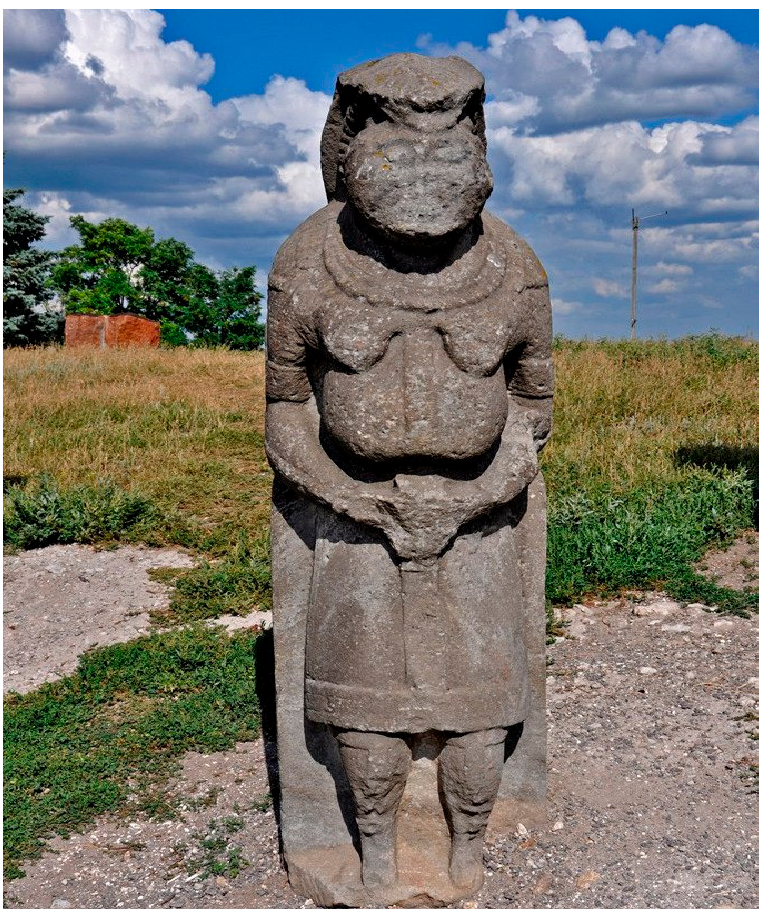
Figure 8. The babas of Polovtsy. Near Kharkiv, 12th century.